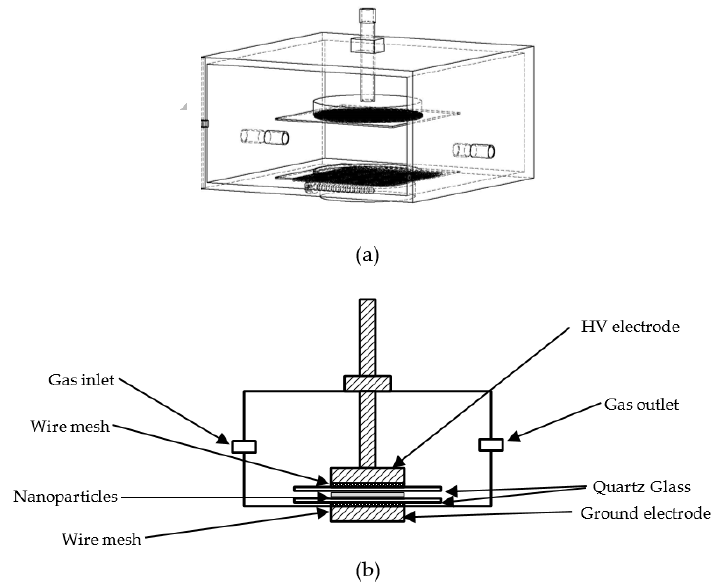
Figure 1. Schematic diagram of atmospheric pressure plasma test cell ( a ) 3D; ( b ) 2D.